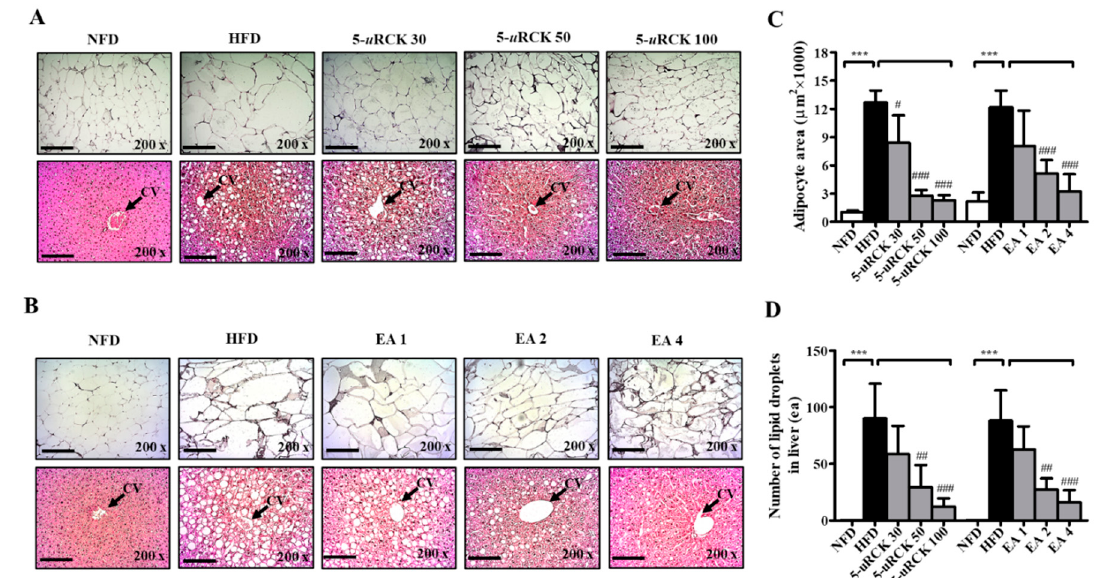
Figure 11. Effects of 5- u RCK and ellagic acid on histological changes and lipid accumulation in eWAT and liver tissues of HFD-induced obese mice. Histological changes were determined via H&E staining in eWAT and liver tissue sections (magnification, ×200) of mice from the ( A ) 5- u RCK and ( B ) ellagic acid pretreated groups. The arrow indicates the central vein (CV). ( C ) The adipocyte size was quantified microscopically from representative sections (n = 18). ( D ) The number of lipid deposits in H&E-stained livers was calculated in at least five images in each group. *** p < 0.001 vs. NFD group; # p < 0.05, ## p < 0.01 and ### p < 0.001 vs. HFD group. Scale bars = 200 μ m.